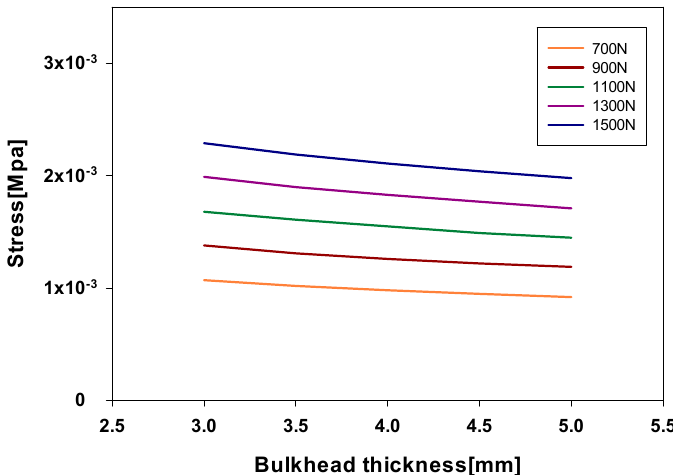
Figure 22. Shows the variation of vertical displacement on the magnet coupler versus bulkhead wall thickness and blade / hub assembly